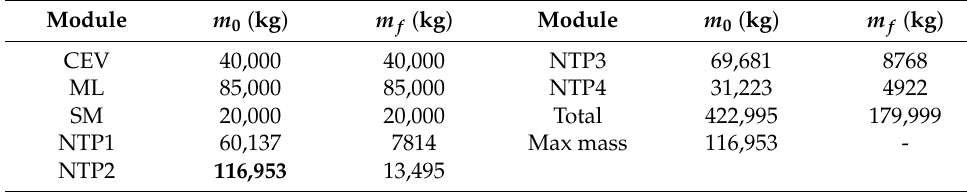
Table 15. Mass scale of Architecture-7.